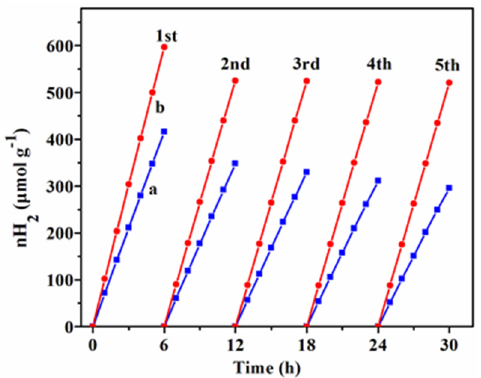
Figure 8 The recycling photocatalytic experiments of (a) TiSi 2 and (b) WS 2 ‐ 1/TiSi 2 ‐ 723.